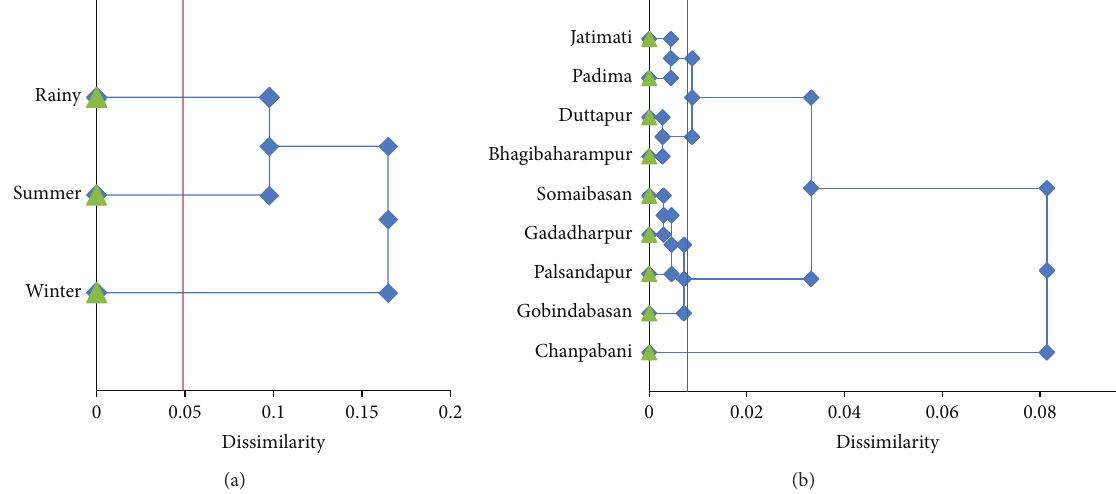
Figure 2: AHC analysis showing distribution pattern of Bacillus spp. (a) in different seasons and (b) in different places.